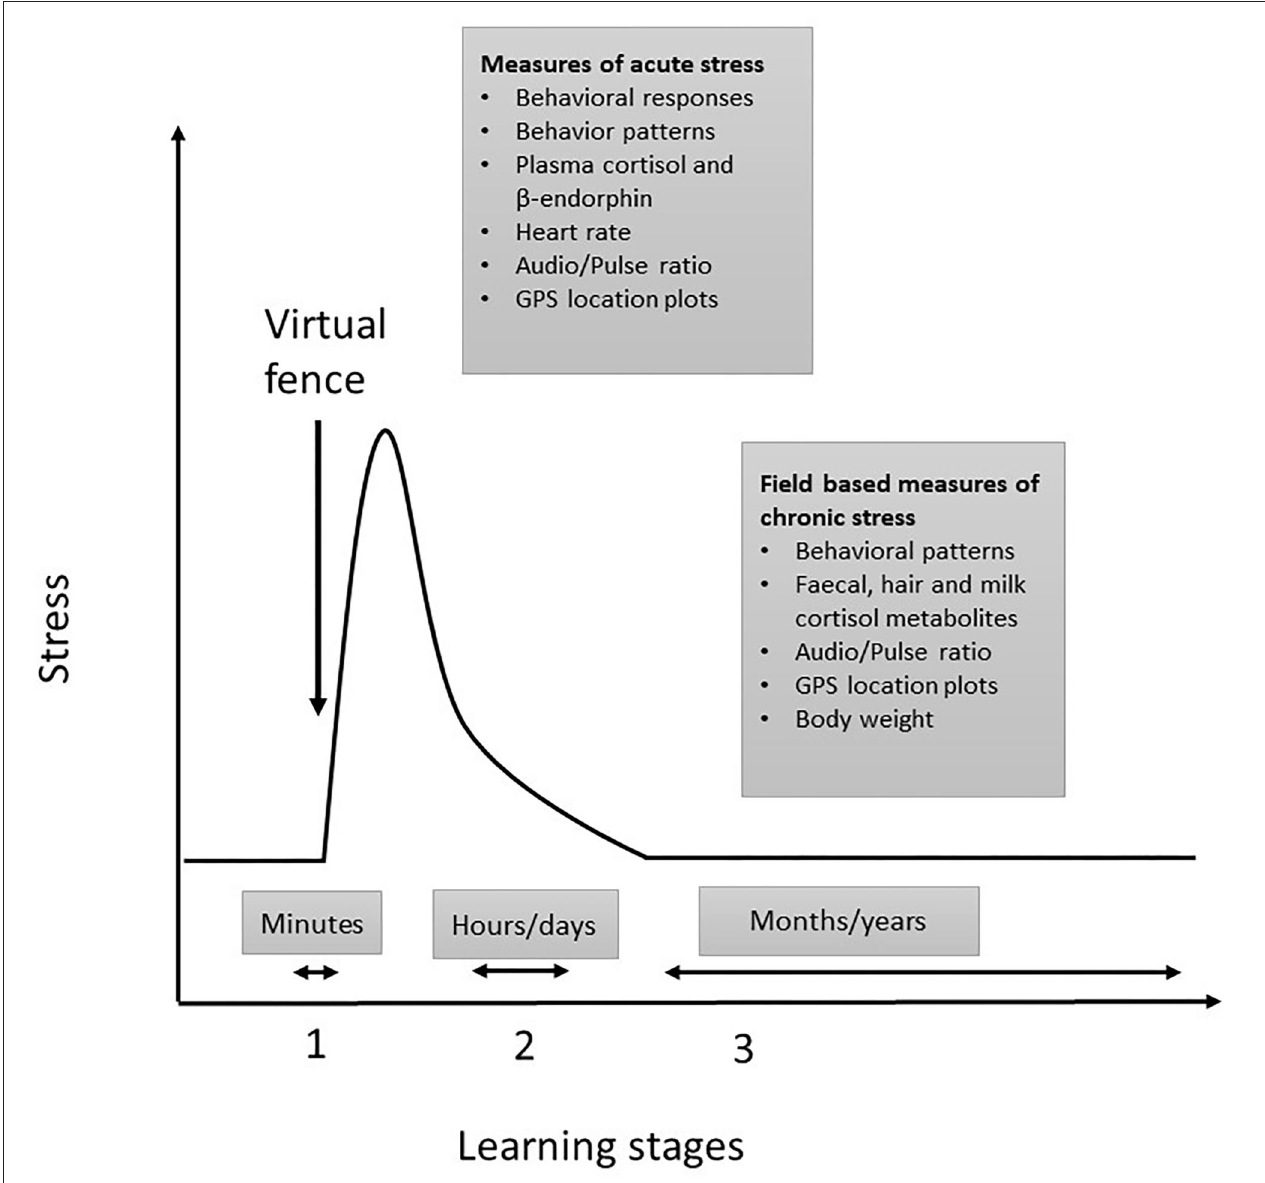
FIGURE 1 | Proposed relationship between learning the virtual fence and stress in livestock. Stage 1 represents the acute phase of learning when animals cannot avoid receiving the electrical pulse and this induces an acute stress response. Stage 2 describes animals adapting to the virtual fence. Stage 3 is where associative learning has occurred, and animals can control their interaction with the fence and avoid receiving the electrical pulse. Relevant measures for acute and chronic stress responses are listed within the text